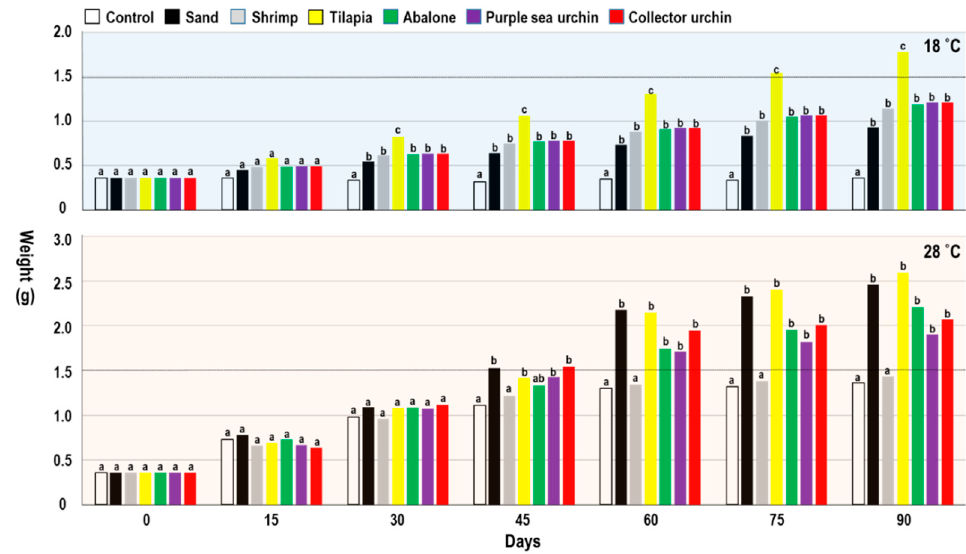
Figure 5. Laevistrombus canarium . Indoor polyculture experiments. Mean (± sd) weight of juveniles at various periods of coculture treatments (control, sand, cocultured with shrimp, tilapia, abalone, purple sea urchin, or collector urchin) at two temperature regimes (18, 28 ◦ C). Different letters indicate statistically significant differences (Tukey’s HSD; p < 0.05) between coculture treatments at each sampling day (0 to 90th day post-initiation of the experiment). Table 3. Laevistrombus canarium . Mean (±sd) of weight, shell length, shell width, shell depth, survival rate, and daily growth rate of juveniles after 90 days of coculture treatments (control, sand, cocultured with shrimp, tilapia, abalone, purple sea urchin, or collector urchin) at two temperature regimes (18, 28 °C). 18 ◦ C Control SL